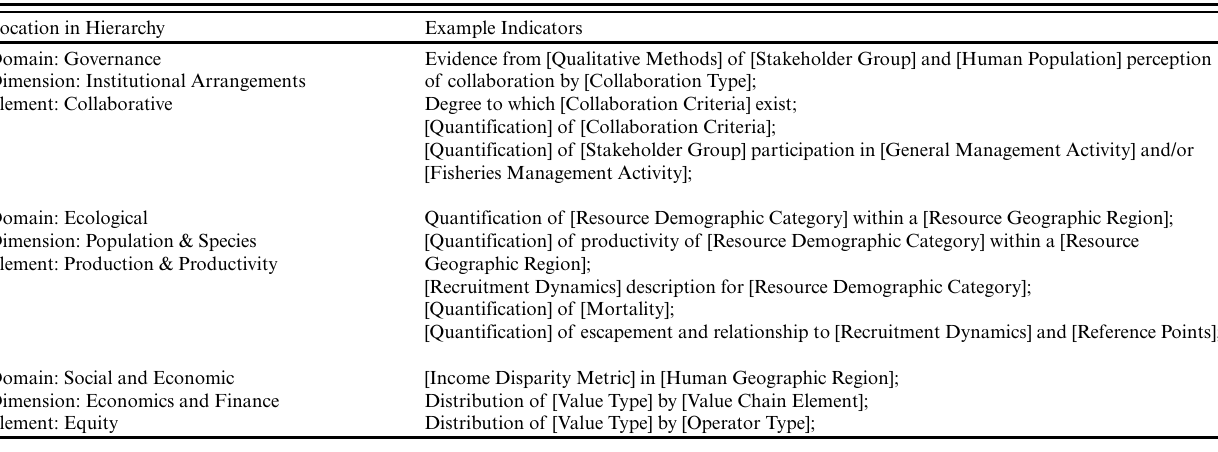
Table 4 . Example indicators. Location in